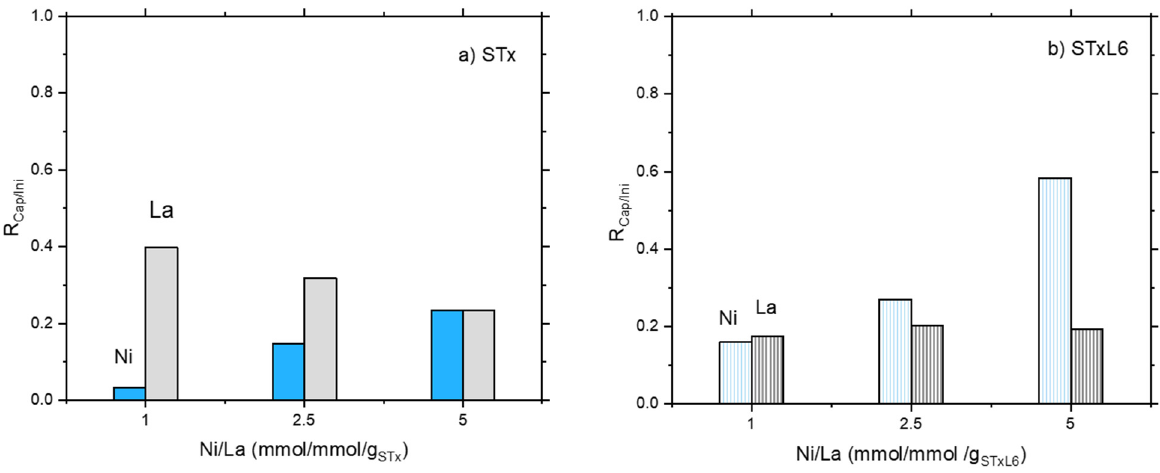
Figure 1. The ratio between metal capture and contacted metal as a function of Ni/La ratio in the initial solution: ( a ) unmodified STx and ( b ) modified STxL6.